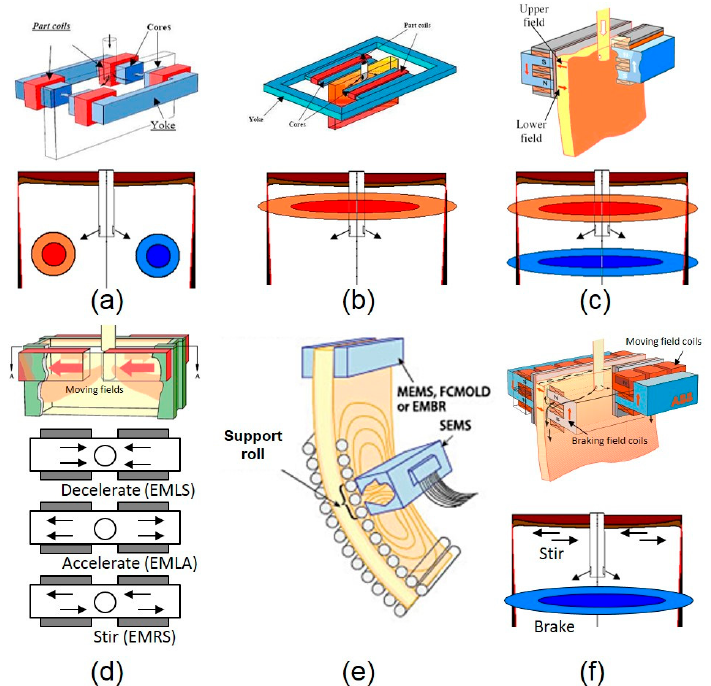
Figure 1. Types of electromagnetic systems showing hardware and field shape: ( a ) local Electromagnetic Braking (EMBr), ( b ) single-ruler EMBr, ( c ) double-ruler EMBr, ( d ) Electromagnetic Level Stabilizer (EMLS), Electromagnetic Level Accelerator (EMLA), and Electromagnetic Rotating Stirrer (EMRS) moving field systems, ( e ) Strand EMS (SEMS), and ( f ) combined fields system.